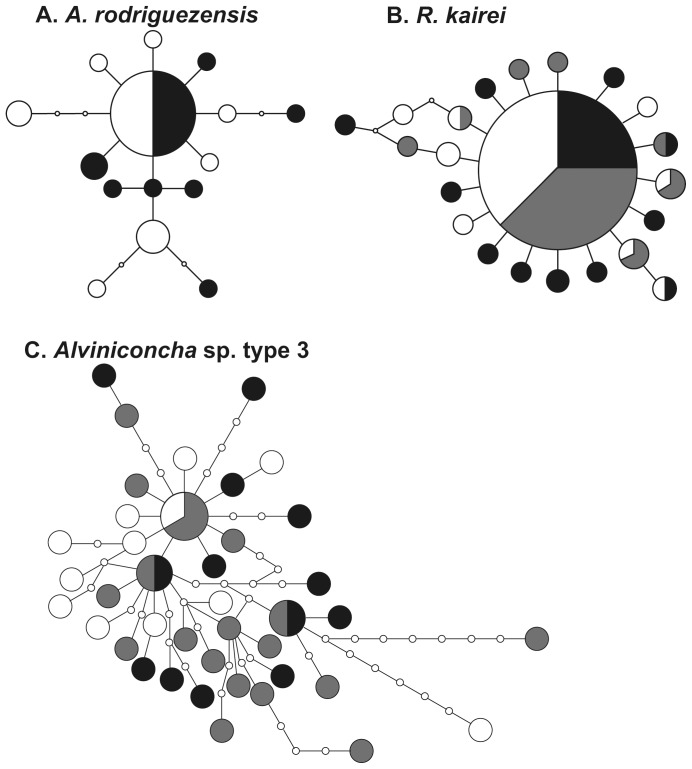
Haplotype networks of the four representative species in the CIR.A, A. rodriguezensis; B, R. kairei; and C: Alviniconcha sp. type 3. Black, population in the Kairei field; gray, population in the Edmond site; and white, population in the Solitaire field.